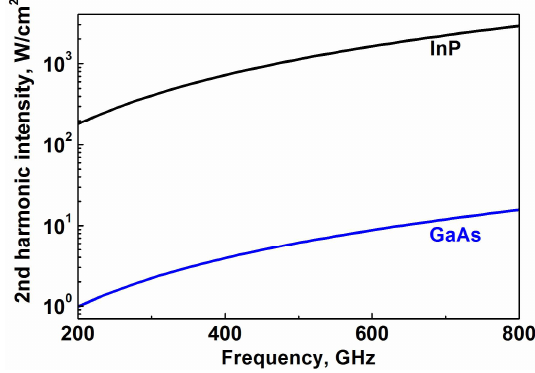
Fig. 1. The estimated second harmonic intensity vs. funda- mental frequency for 5 cm long GaAs and InP crystals un- der fundamental radiation power of 50 kW/cm 2 . Data on the refractive index for InP and GaAs is taken from Ref [28] and Ref [25],